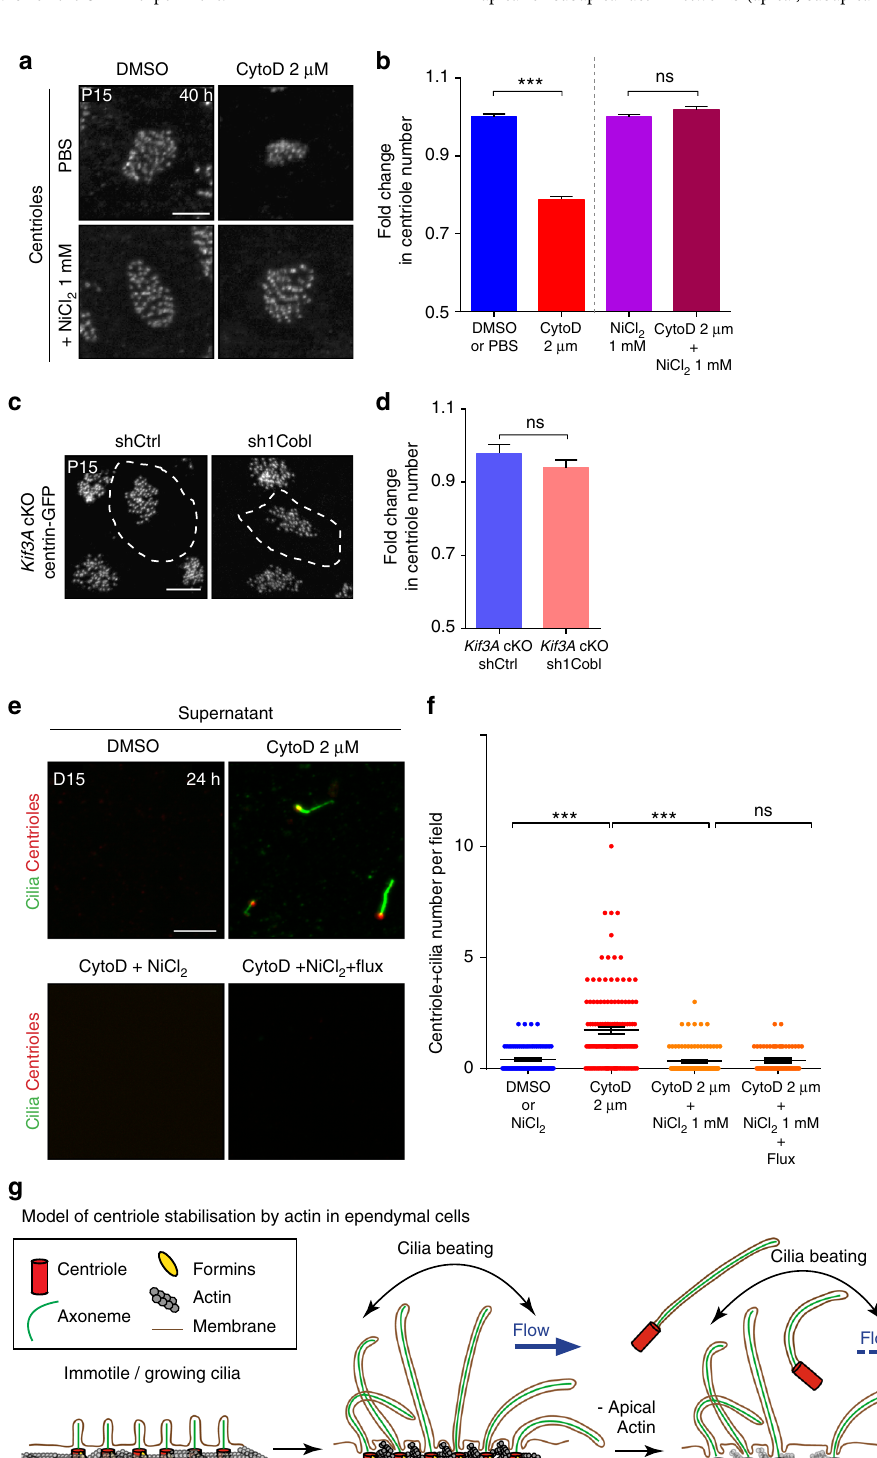
Optical imagery . Images (230-nm or 210-nm z-steps) of fi xed samples were obtained with either an inverted epi fl uorescence microscope (Zeiss Axio Observer Z1) equipped with a Plan-Apochromat ×63 (NA 1.4 oil-immersion) objective, a Zeiss Apotome with an H/D grid, a CCD camera (ORCA-ER, Hammamatsu), and Zen2 software, or a confocal microscope (model SP5 or SP8; Leica) with a ×63 (Plan Neo fl uar NA 1.3 oil-immersion) objective and Leica LAS-AF software. Z- stack projections along the entire apical surface or 6 z-stacks encompassing the apical or subapical actin networks (apical, subapical actin) are